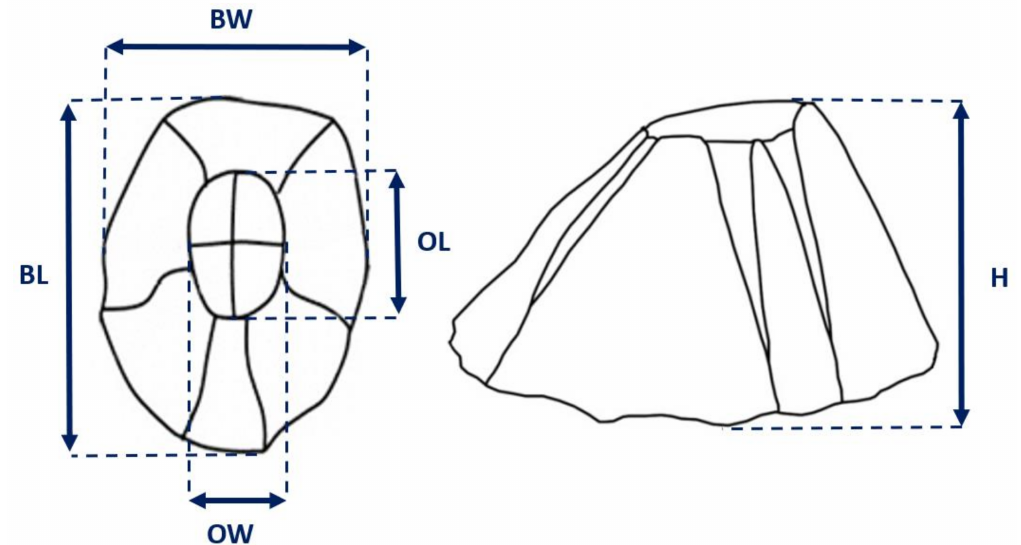
Figure 2. Measured shell dimensions: basal length (BL), basal width (BW), height (H), opercular length (OL), and opercular width